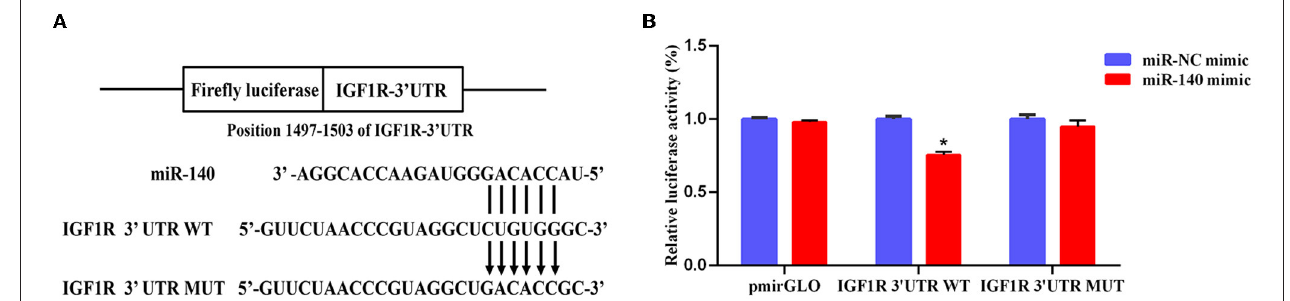
FIGURE 8 | Detection of interactions between miR-140 and IGF1R by dual luciferase reporter system. (A) Binding site sequence of miR-140 and target gene IGF1R. (B) miR-140 mimic was cotransfected with IGF1R 3 ’UTR WT or IGF1R 3 ’UTR MUT to detect the luciferase activity for 48 h. * p < 0.05.